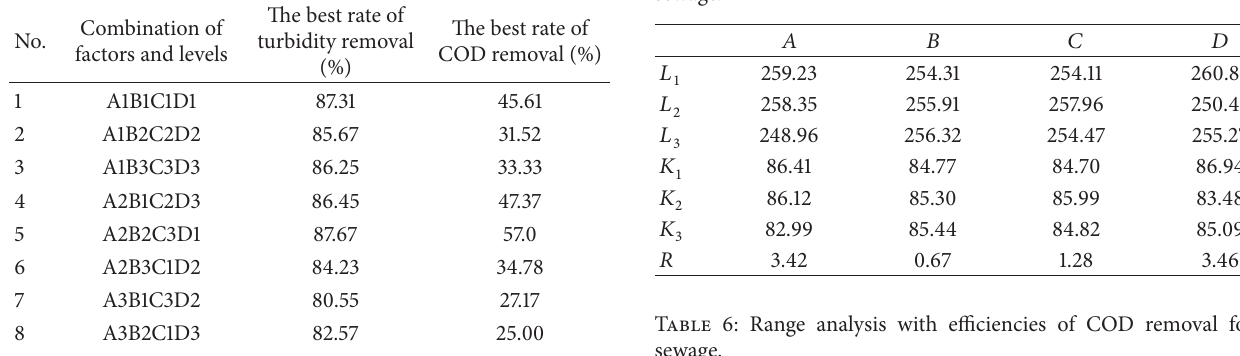
Table 5: Range analysis with efficiencies of turbidity removal for sewage.